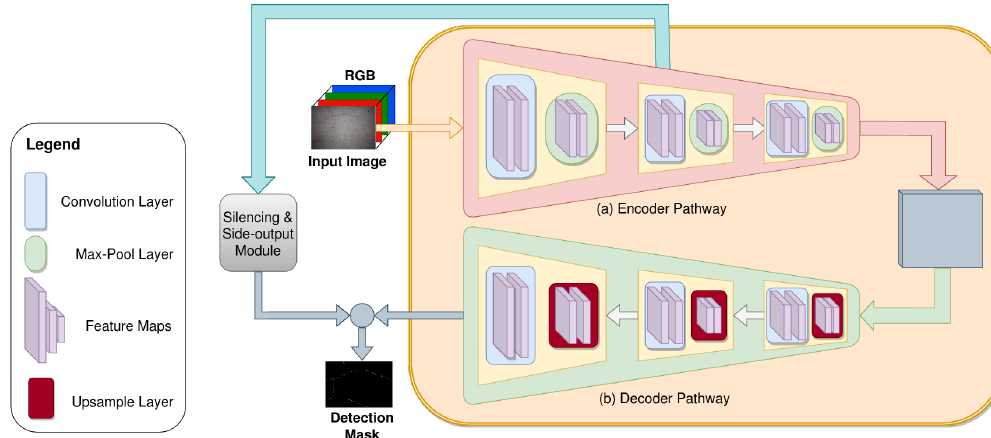
Figure 5. Encoder and decoder module of Attention Network (ANet)-feature silencing module (FSM) architecture. Each encoder performs a 7 × 7 convolution and max-pooling operation. The decoders up-sample this low dimensional feature space into upper dimension using bi-linear interpolation. The feature space decoding is performed by the convolution operation in each